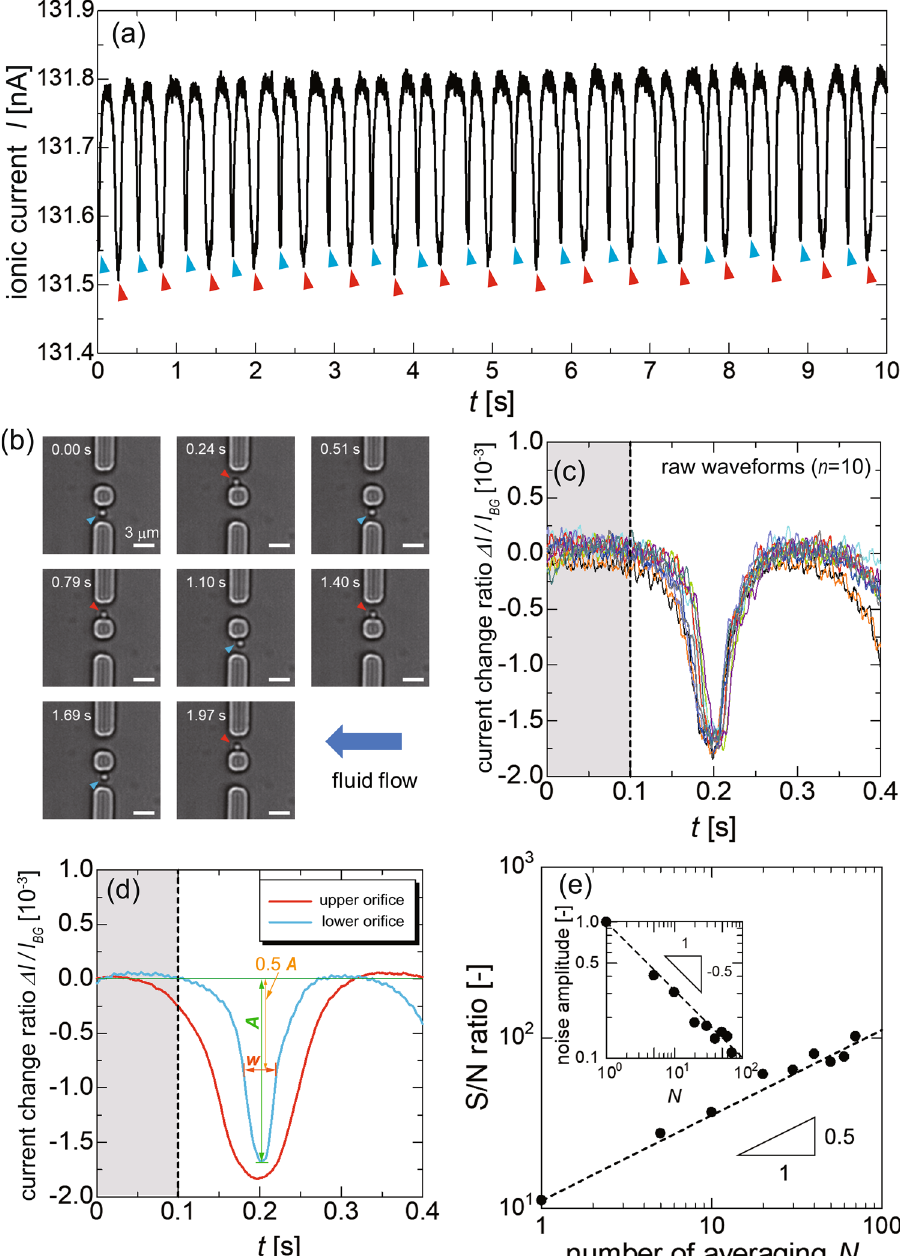
Figure 4. Results of the synchronized resistive-pulse analysis using the optical vortex for a single particle with a diameter of 1 µ m under an applied voltage of 1 V. ( a ) Ionic-current, I , waveform acquired with the orbital motion through the double orifice. The red and blue arrows indicate the translocation of the particle through the upper and lower orifices, respectively. ( b ) Snapshots of the translocation of the particle through the double orifice. Scale bars in (b) denote 3 µ m. ( c ) 10 typical waveforms corresponding to the translocation through the lower orifice, in which the ionic-current value is standardized by the background current. ( d ) Resistive-pulse waveforms averaged over 70 translocation events for the upper and lower orifices. A and w respectively denote the pulse amplitude and width which is defined as the full width at half maximum of the waveform. The gray area from 0 to 0.1 s indicates the waveform range used for the analysis of the S/N ratio. ( e ) S/N ratio dependency on the number of pulses N used in the synchronized averaging. The inset shows the decay of the noise amplitude as N increases. In keeping with the theoretical estimation, the noise amplitude of the waveform for N averaged pulses decays inversely proportional to √ N , leading to improvement of the S/N ratio proportional to √ N